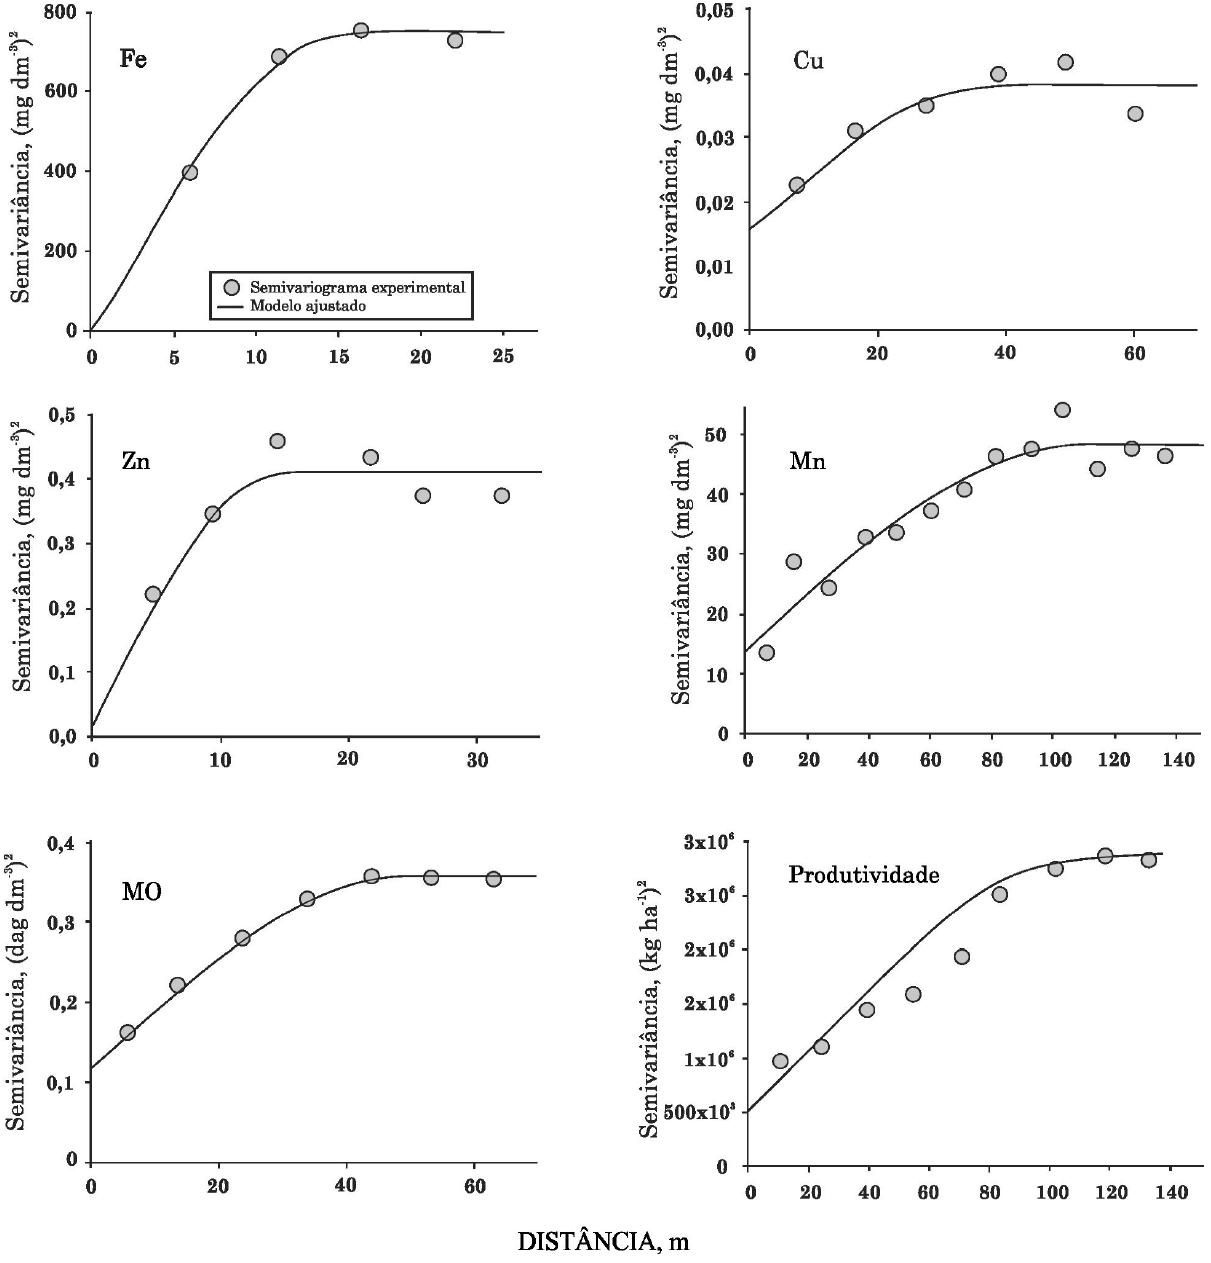
Figura 2. Semivariogramas experimentais ajustados para ferro, cobre, zinco, manganês, matéria orgânica e produtividade da